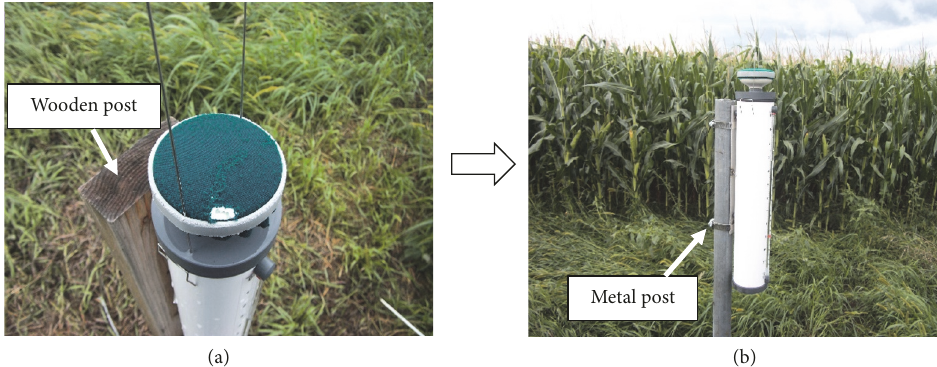
Figure 3: Atmometer mounted in wooden post damaged by mice (a) and mounted on a metal post (b) at Volga site.